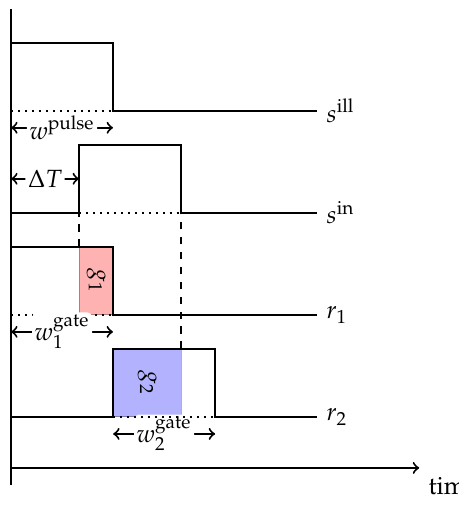
Figure 2. Pulse based camera timings.